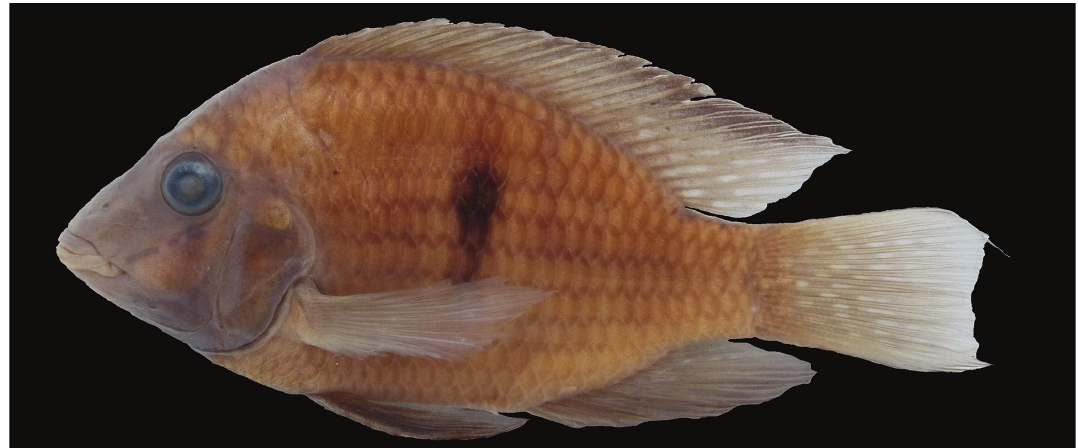
Fig. 1. Gymnogeophagus terrapurpura , new species, ZVC-P 12490, 60.0 mm SL, holotype, cañada de La Lana, rio Santa Lucía basin, Canelones Department,